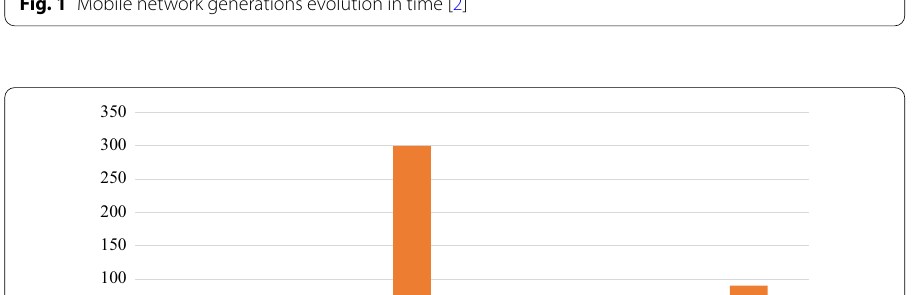
Fig. 1 Mobile network generations evolution in time [2]